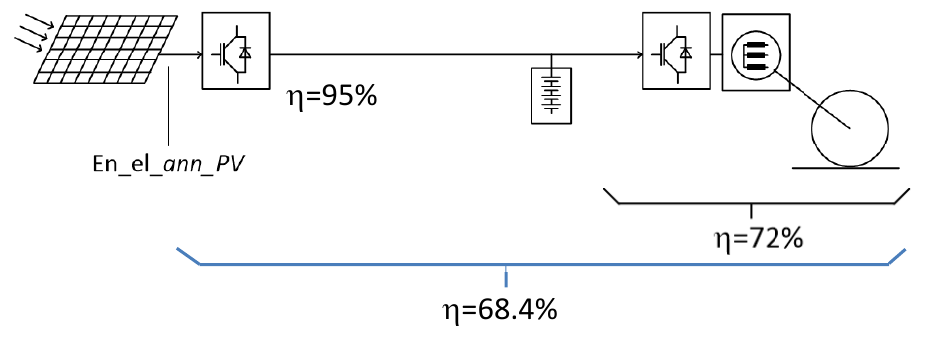
Figure 8. Efficiency of a PV-powered EV (Electric Vehicle).